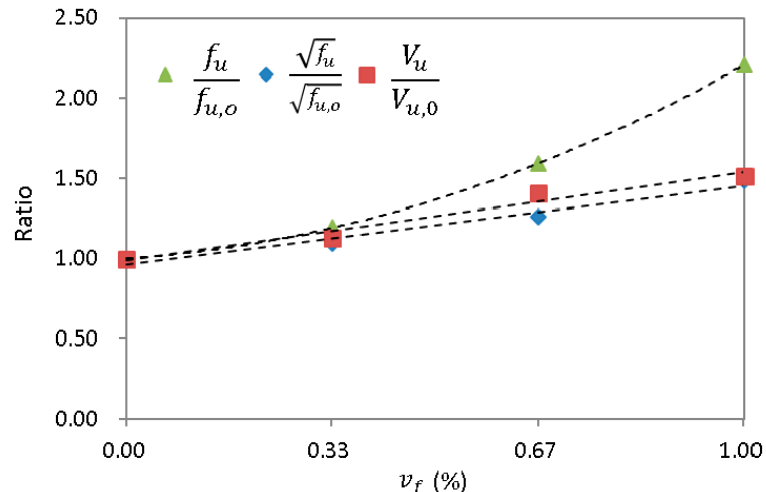
(cid:112) Figure 13. Ratios of the 𝑓 (cid:3048) and (cid:3493)𝑓 (cid:3048) of the SFRC beams and 𝑉 (cid:3048) of the SFRC anchors to those of the f u of the SFRC beams and V u of the SFRC anchors to those of the Figure 13. Ratios of the f u and non-reinforced concrete with increasing fiber volume percentages from zero to 1.00%. non-reinforced concrete with increasing fiber volume percentages from zero to